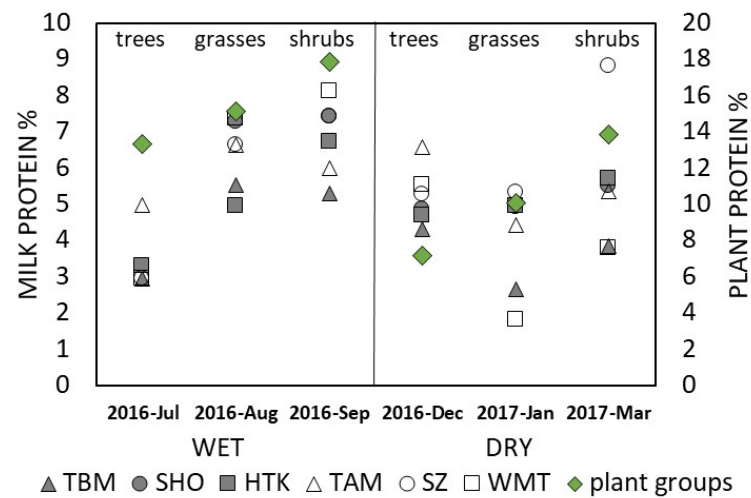
Figure 4. Seasonal changes in milk protein vs. forage protein by three plant groups. Milk and forage protein values were higher during wet season compared to dry season values ( n = 36 milk protein values from six mothers, mothers identified by different symbols; n = 6 mean forage protein values (green symbols) of three different plant groups (trees, grasses, shrubs, according to Table 4).